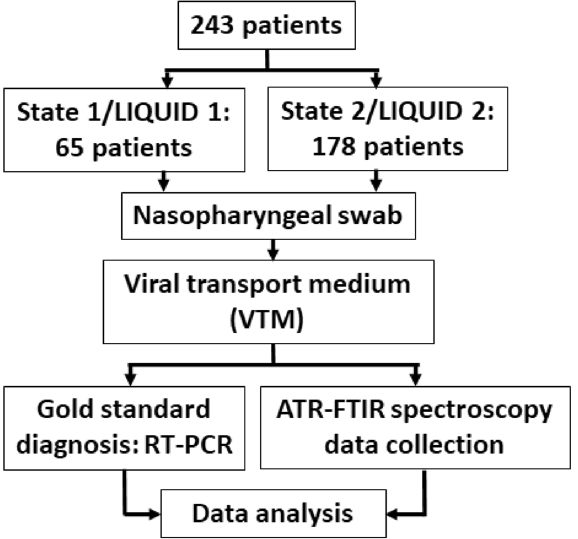
Figure 11. Data collection and analysis